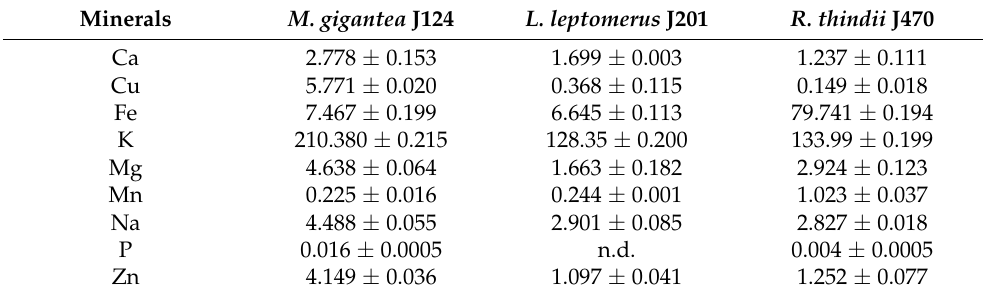
Table 3. Mineral content of edible mushrooms in dry